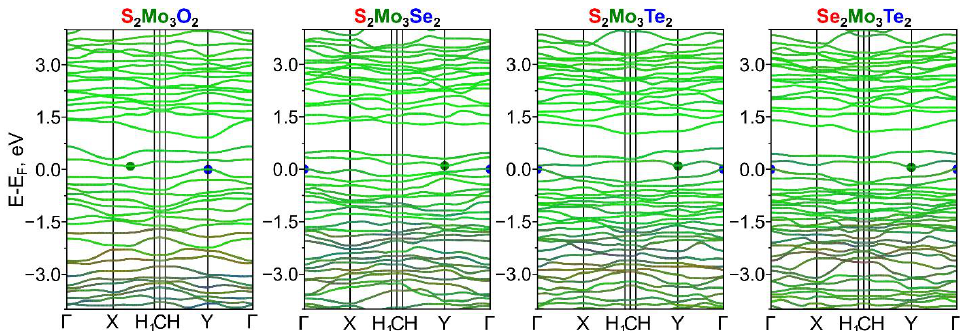
Figure 4. Atom-resolved electronic band structure of dynamically stable Janus Ch 1 2 Mo 3 Ch 2 2 (Ch 1 /Ch 2 = O, S, Se, Te) Chevrel phases. The contributions from Ch 1 , Ch 2 , and Mo atoms are indicated with red, blue, and green colors, respectively. Table 3. Band gap values (E g ) and vacuum potential difference (ΔΦ) for opposite sides of dynami-